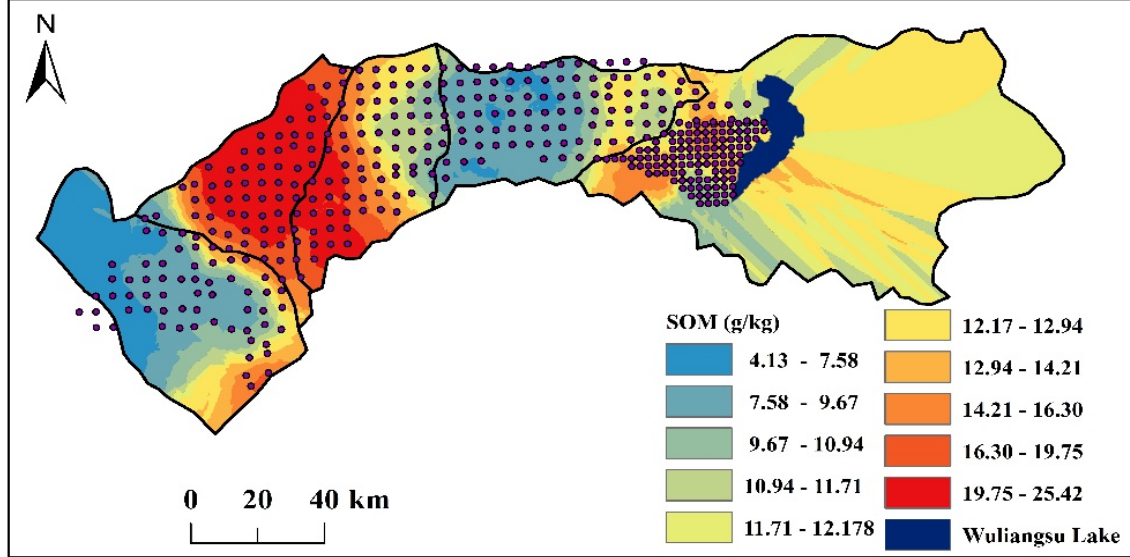
Figure 2. The distribution of the SOM from samples in Hetao Irrigation District (0–20 cm).